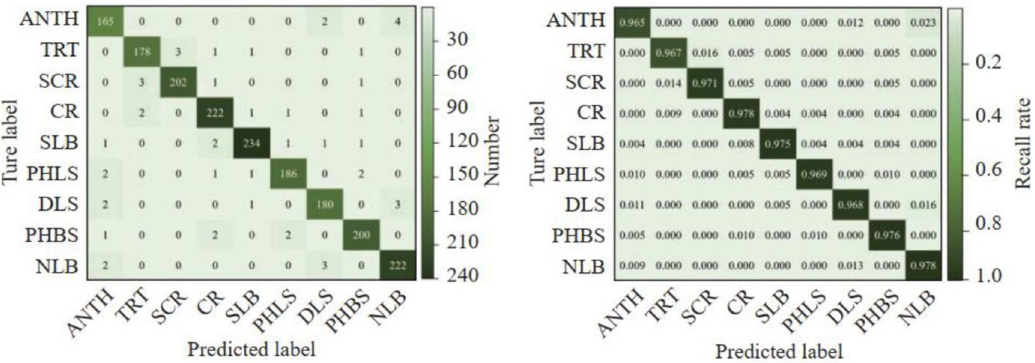
Fig 9. ANTH, TRT, SCR, CR, SLB, PHLS, DLS, PHRS and NLB represent Anthracnose leaf blight, Tropical rust, Southern maizerust, Common rust, Southern leaf blight, Phaeosp haeria leaf spot, Diplodia leaf streak, Physoderma brown spot and Northern leaf blight respectively; The darker diagonal values in figures represent the number of correct classifications and the recall rate of each category,